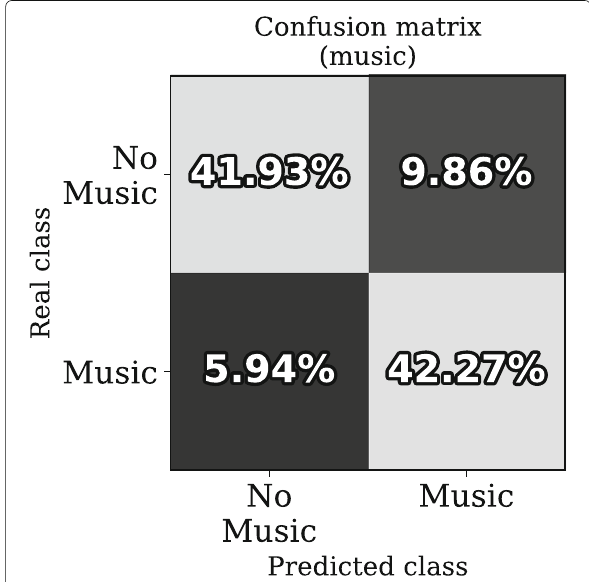
Fig. 7 Confusion matrix of the best network setting for music event detection ( CNN 7 × 7 with L = 6 and N = 128). The percentages indicate the total amount of test segments in each possible real class-predicted class